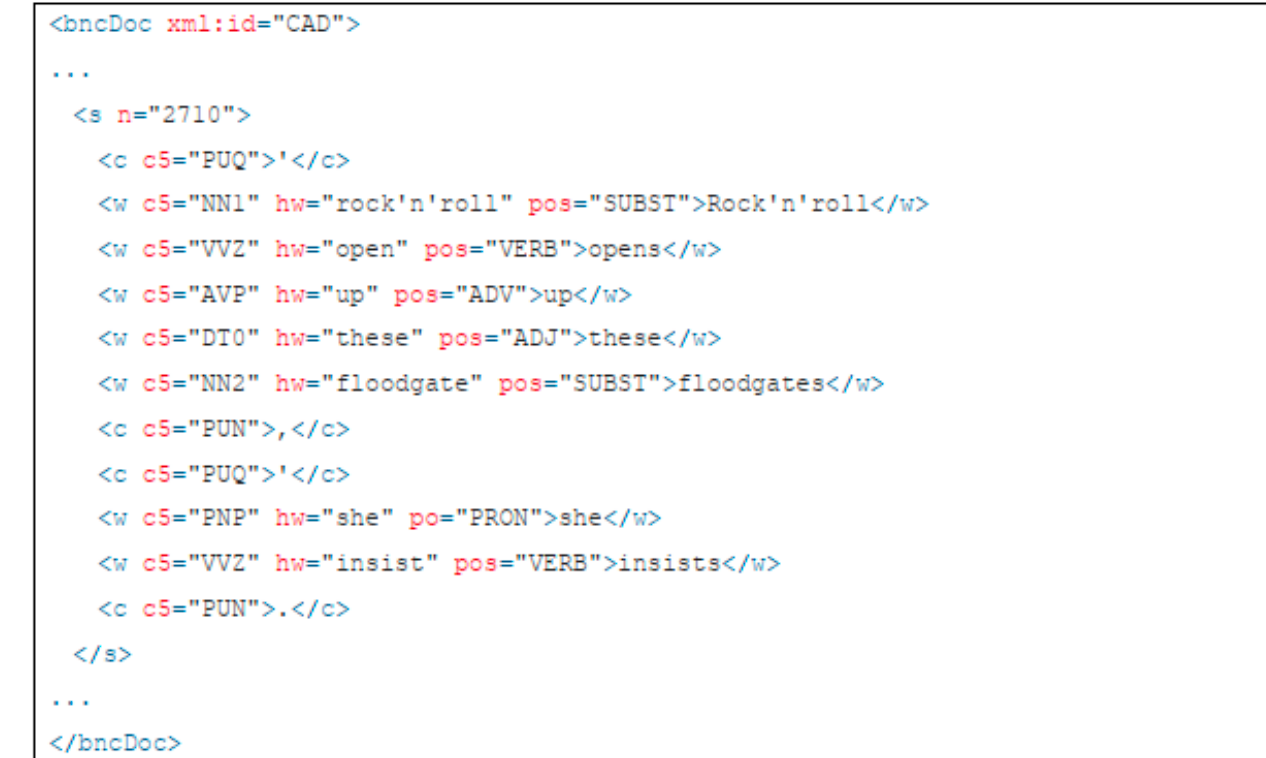
Figure 6. A sample sentence from the BNC formatted in XML.